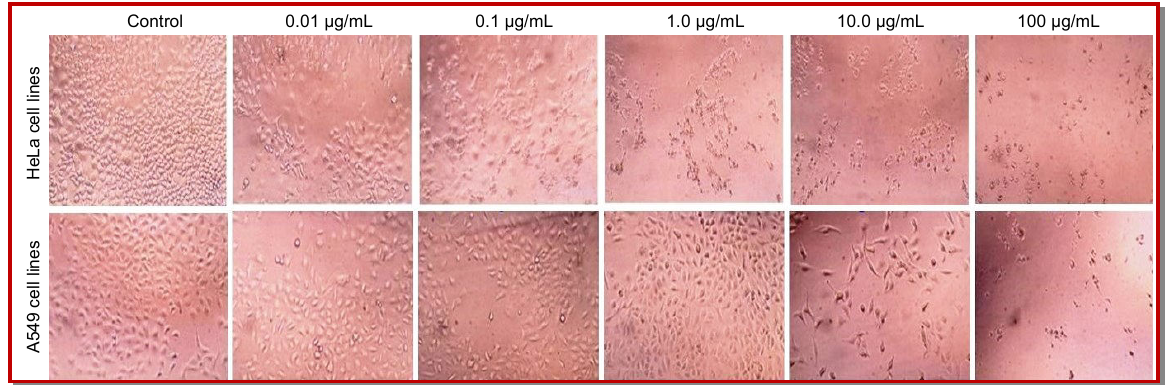
Figure 3: Anti-proliferative activity of quercetin against HeLa and A549 cell